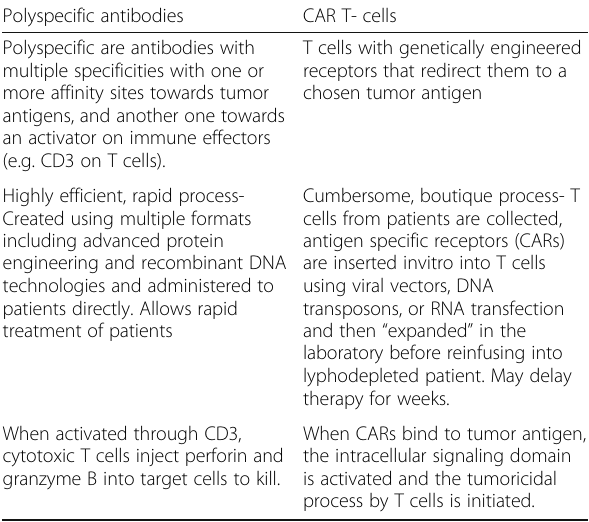
Table 5 Comparing bi-specific and tri-specific antibody therapy to CAR T- cell therapy Polyspecific